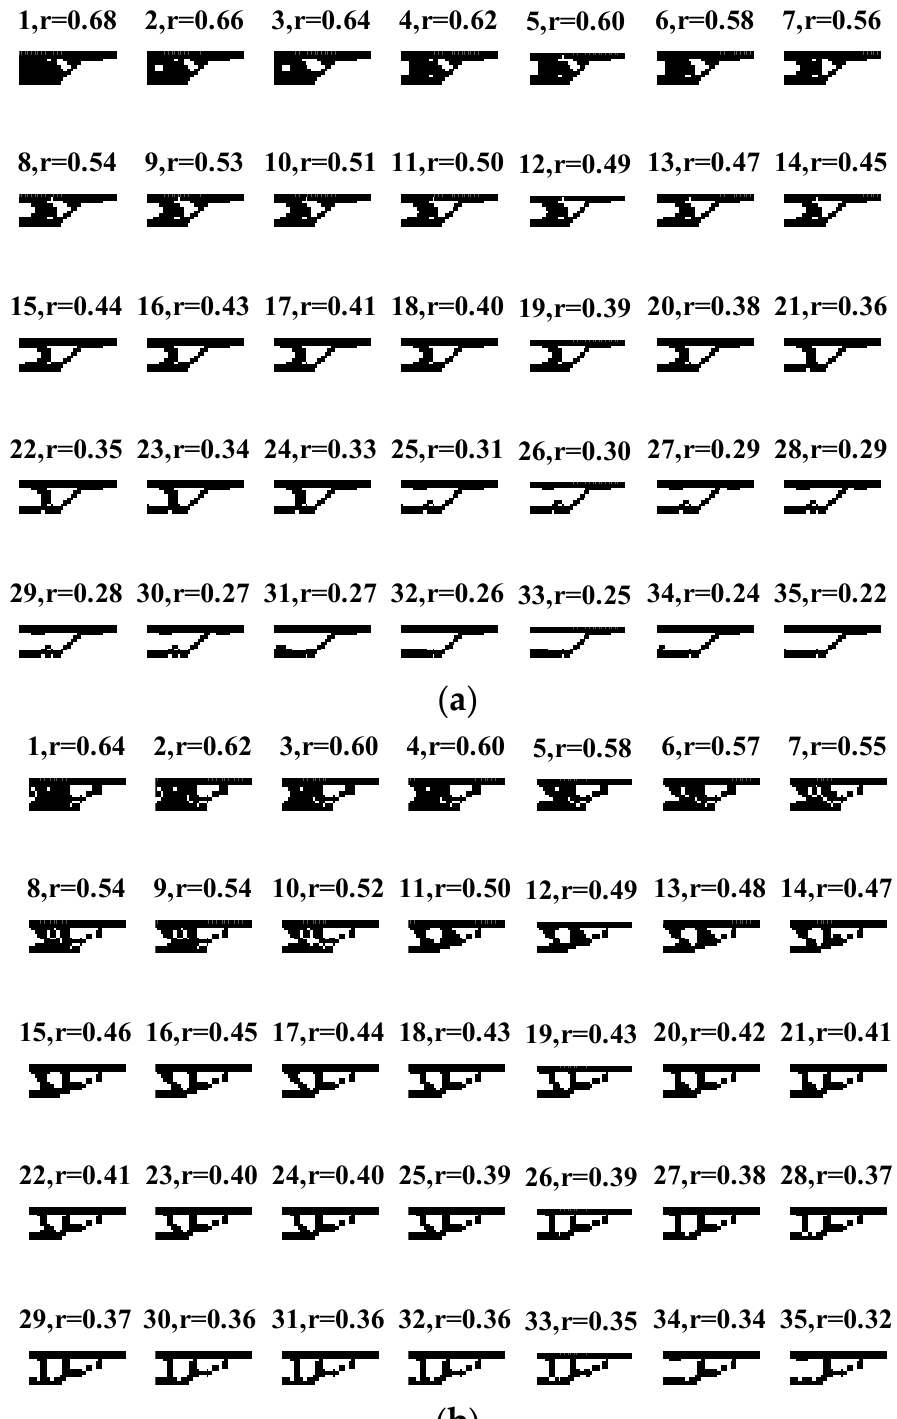
Figure 7. Topologies of MOP4: ( a ) OMPBIL with multi-grid; and ( b ) MPBIL without multi-grid.